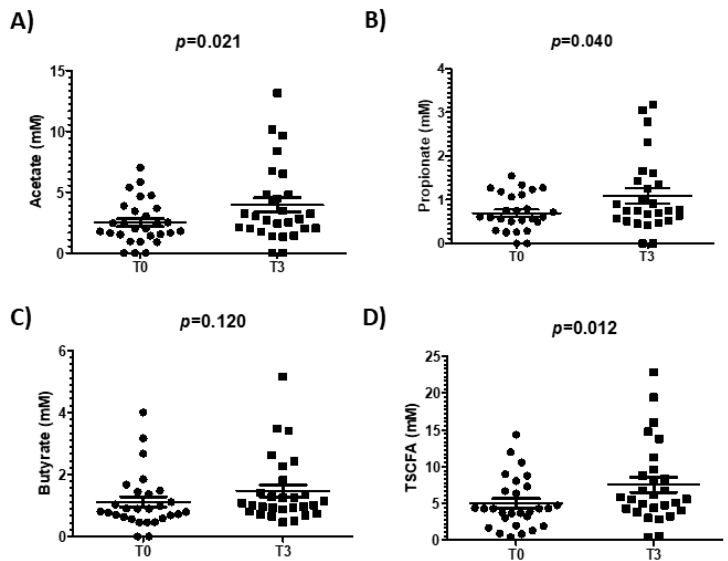
Figure 4. SCFA profile before and after the intervention for all the participants. Acetate ( A ), propionate ( B ), butyrate ( C ) and total SCFA ( D ) levels measured by GC for all the participants. A paired t-test was used to test significant differences in SCFA levels before and after the intervention. Results are presented as mean ± SEM.